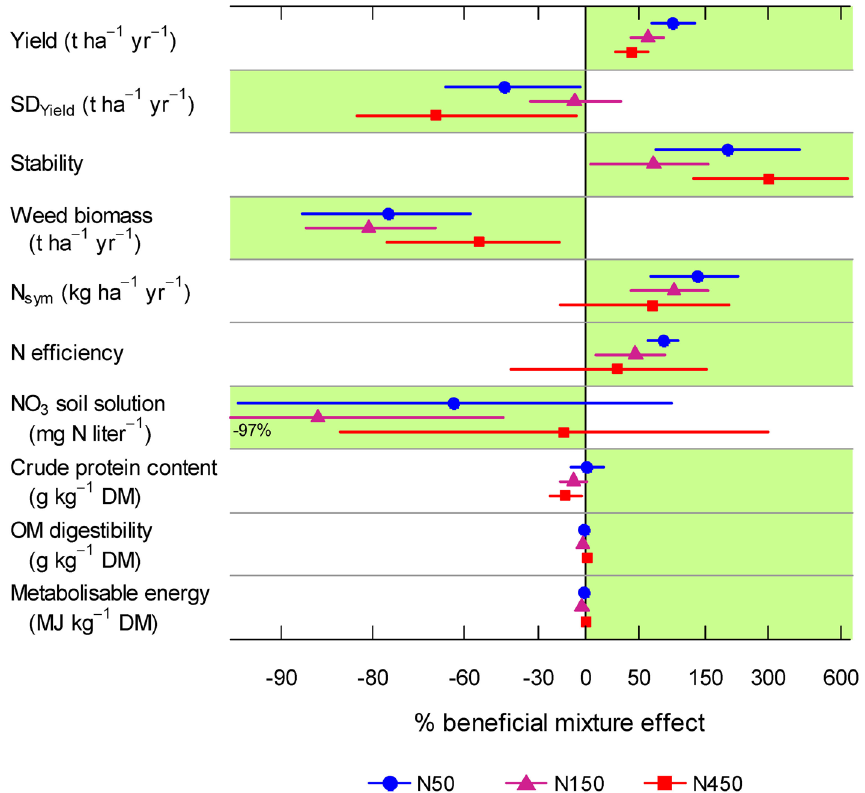
Figure 2. Percent of beneficial mixture effect (mixture performance greater than the average of monocultures) of the four-species equi-proportional mixture for ten functions at three N fertilisation treatments (N50: preferred direction of the mixture effect is shaded in green. Point estimates are based on multivariate regression analysis (Table 2) and error bars represent 95% confidence intervals (CIs). Functions whose CI does not include 0 can be considered to reveal a significant mixture effect. Stability, weed biomass, and NO 3 in soil solution were back-transformed to linear scale to calculate beneficial mixture effects. One extreme CI is cut and given as number, and the X axis is log-scaled to equalise distances on both sides of